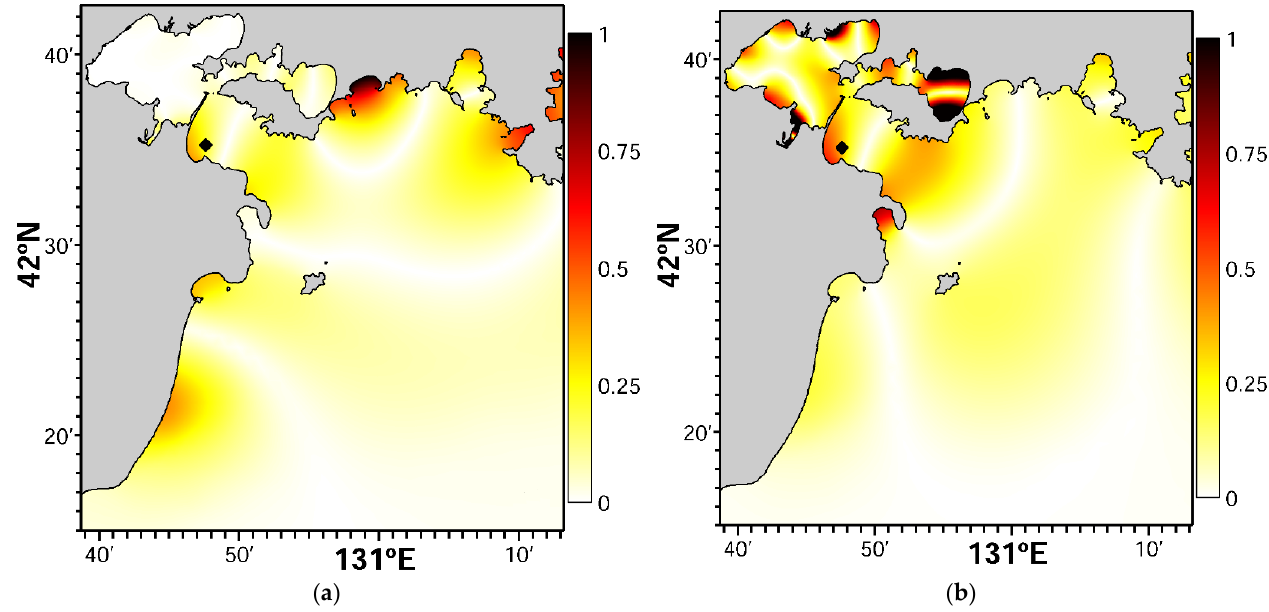
Figure 8. Distribution of oscillation amplitude with period of 24.83 min during the zonal wind ( a ) and with the period of 27.035 min during the meridional wind ( b ). Diamonds—points of oscillation